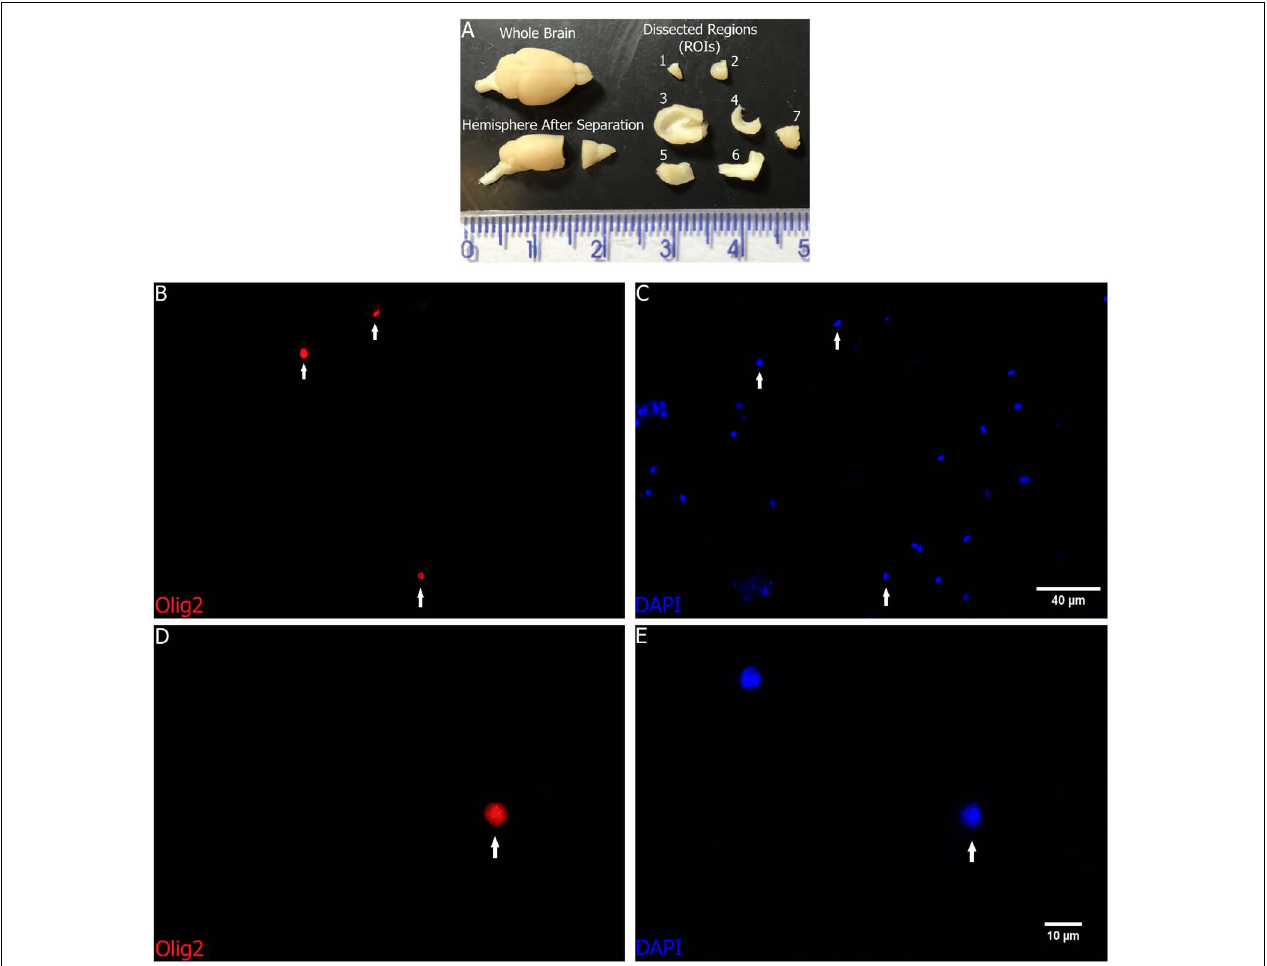
FIGURE 1 | Regions of interest before and after fractionation. All dissected ROIs in (A) : Upper left – Whole brain; Lower left – A hemisphere after separation of anterior cortex plus olfactory bulb from the rest of the brain; Upper and lower right – 1: olfactory bulb , 2: anterior neocortex , 3: remaining cortex (including the piriform cortex), 4: hippocampus , 5: diencephalon plus basal ganglia , 6: brainstem, and 7: cerebellum . Scale in centimeters. (B–E) Representative images from distinct fields with (B,C) lower magnification, and (D,E) higher magnification of the cortex nuclei suspension after fractionation, with staining and immunocytochemistry to Olig2 (B,D) and DAPI (C,E) . The images show nuclei doubly stained with DAPI and Olig2 (arrows). Scale bars: 40 µ m (B,C) and 10 µ m (D,E)